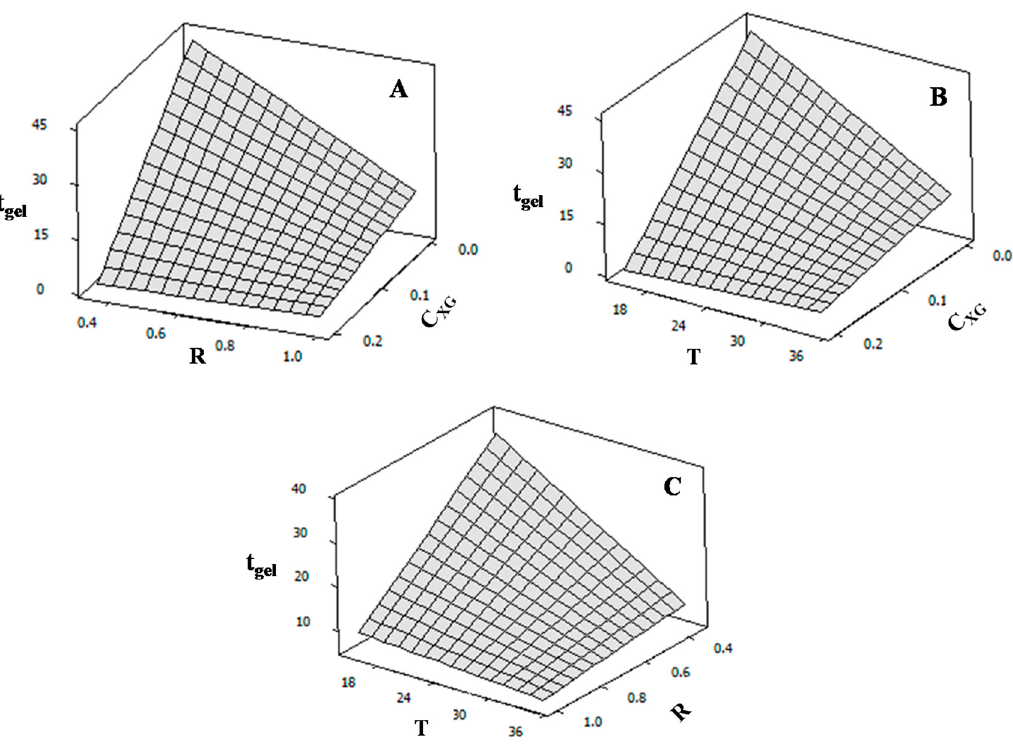
Figure 4. Response surface plots: ( A ) t gel (min) as a function of GDL mass fraction/NaCAS mass fraction ratio (R) and xathan gum concentration (C XG : wt %); ( B ) t gel (min) as a function of temperature (T: ◦ C) and xathan gum concentration (C XG : wt %) and ( C ) t gel (min) as a function of GDL mass fraction/NaCAS mass fraction ratio (R) and T (°C).